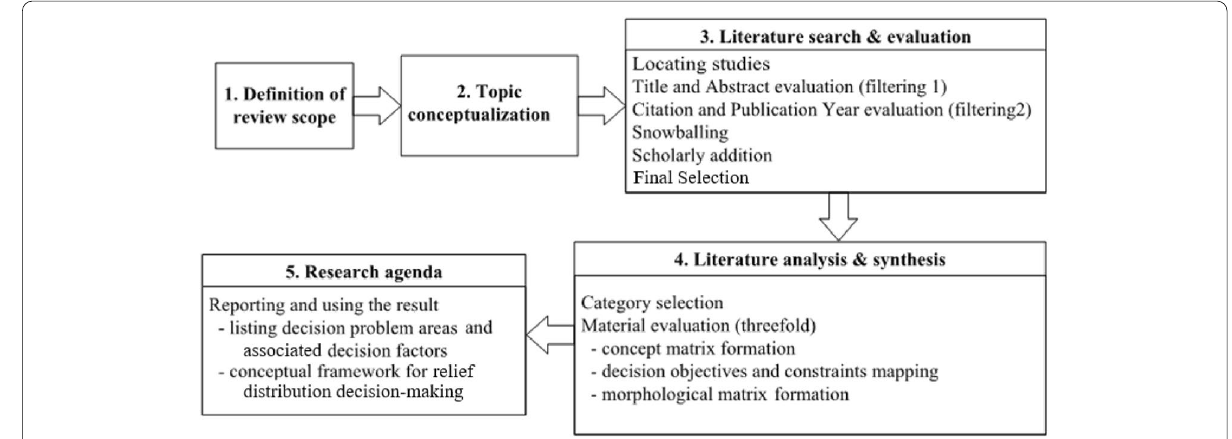
Fig. 1 The framework for this systematic literature review (adapted from vom Brocke et al. 2009)